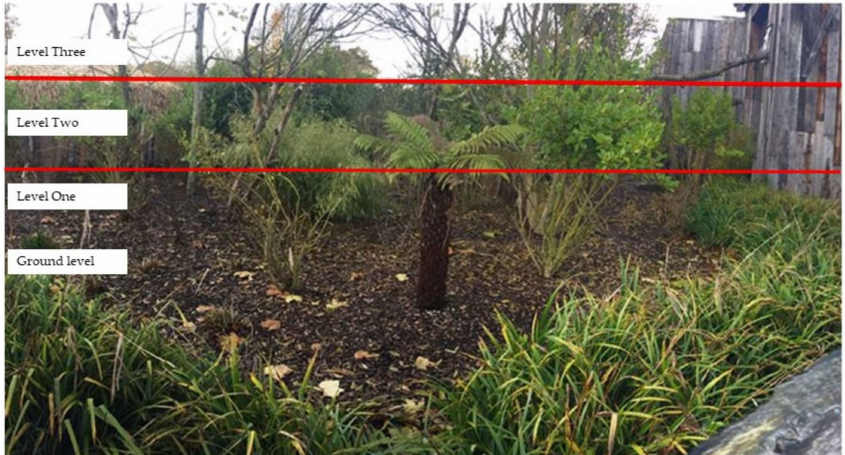
Figure A3. Image outlining pre-determined height levels used throughout data collection within the outdoor